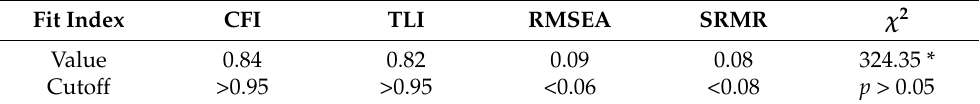
Table 4. Confirmatory Factor Analysis model fit indices (N = 119). Fit Index